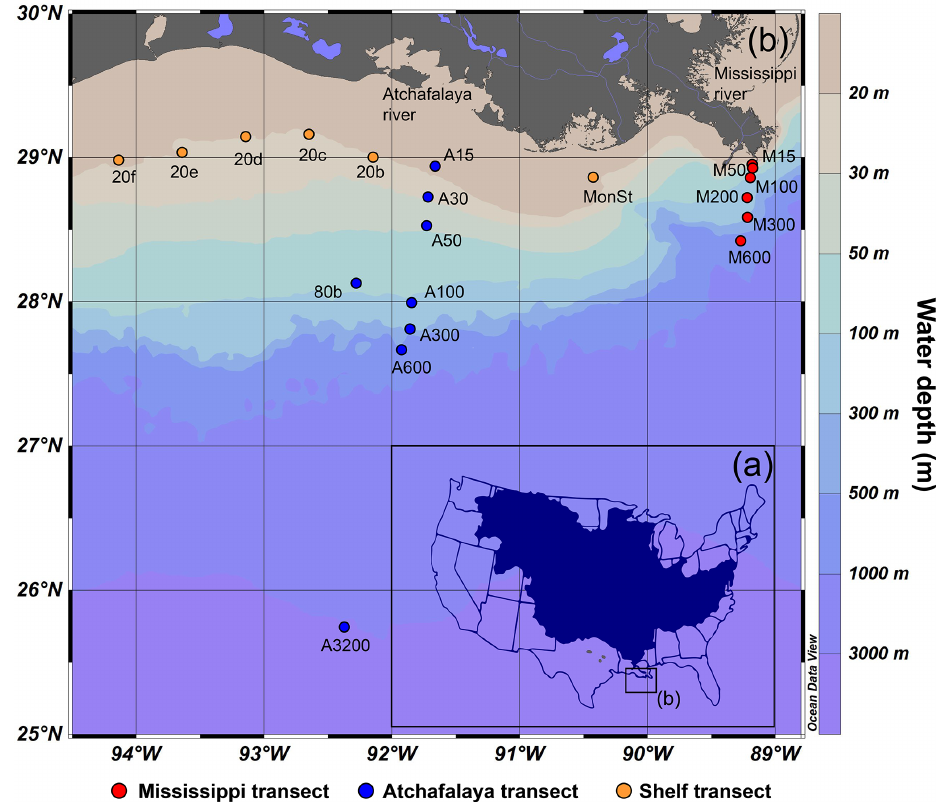
Figure 1. (a) The catchment of the Mississippi–Atchafalaya River (MAR) system and (b) the locations of marine surface sediments in the northern GoM used for this study. Surface sediments have been collected along three transects: the land–sea transects of the Mississippi River (15–600m water depth, samples M15, M50, M100, M200, M300 and M600), the Atchafalaya River (15–3200m water depth, samples A15, A30, A50, 80b, A100, A300, A600 and A3200), and a shelf transect following the river plume at the 20m isobar (samples 20f, 20e, 20d, 20c, 20b,